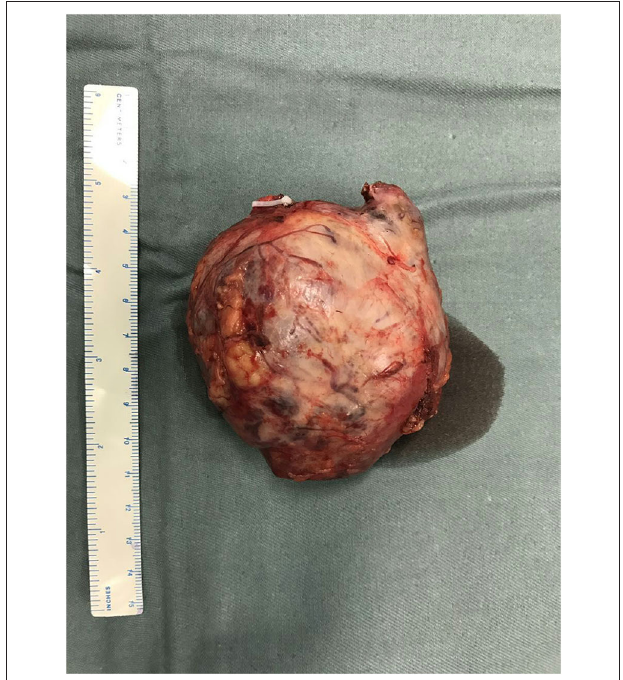
FIGURE 2 | Gross section of the tumor. A solid tumor of 8cm was removed, with a smooth capsule and a clear boundary with renal parenchyma.